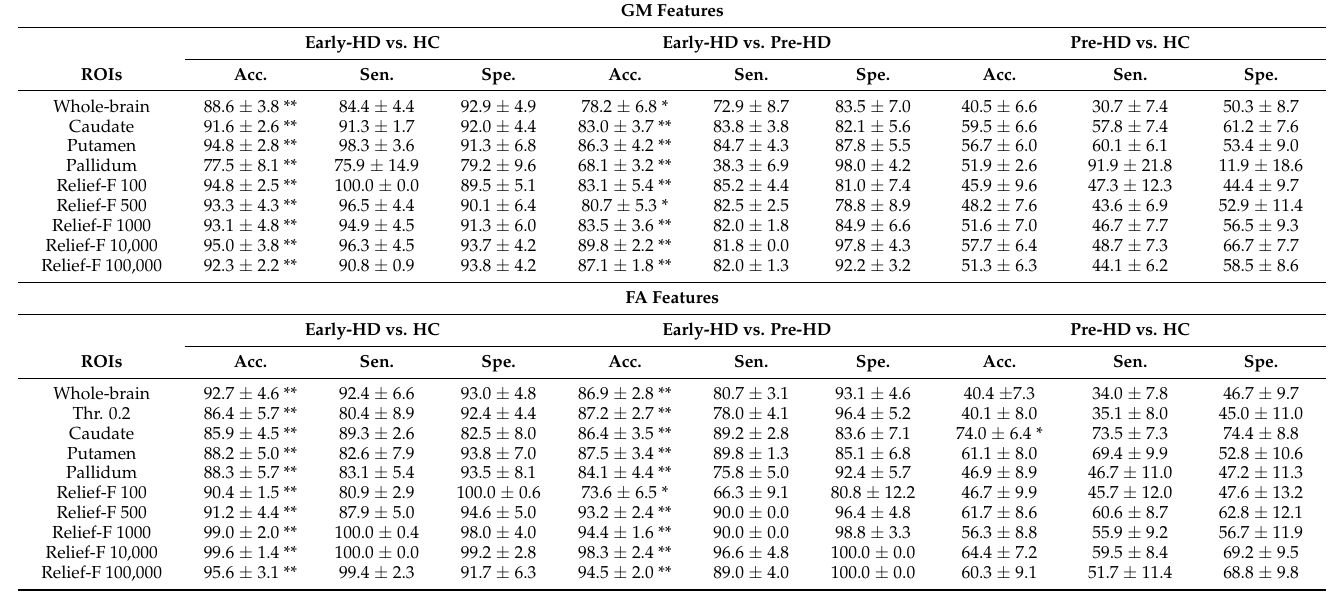
Table 2. Results using GM and FA features separately. Average accuracy, sensitivity, and specificity values (%), and standard deviations, from each binary classification using support vector